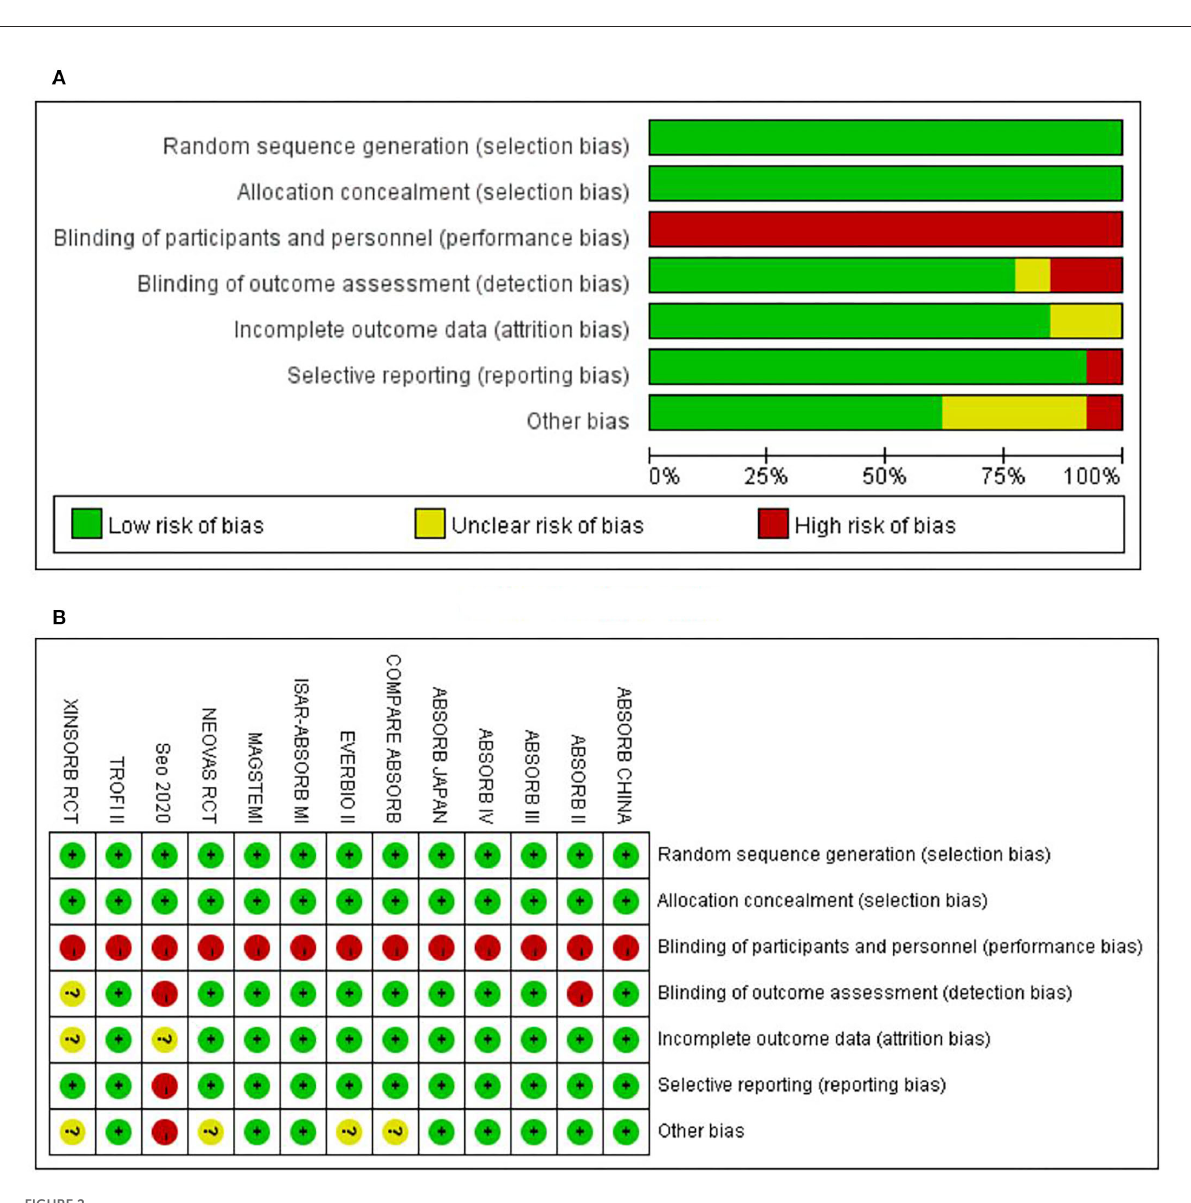
FIGURE2 Assessment on risk of bias. (A) The overall risk of bias. (B) Risk of bias for specific